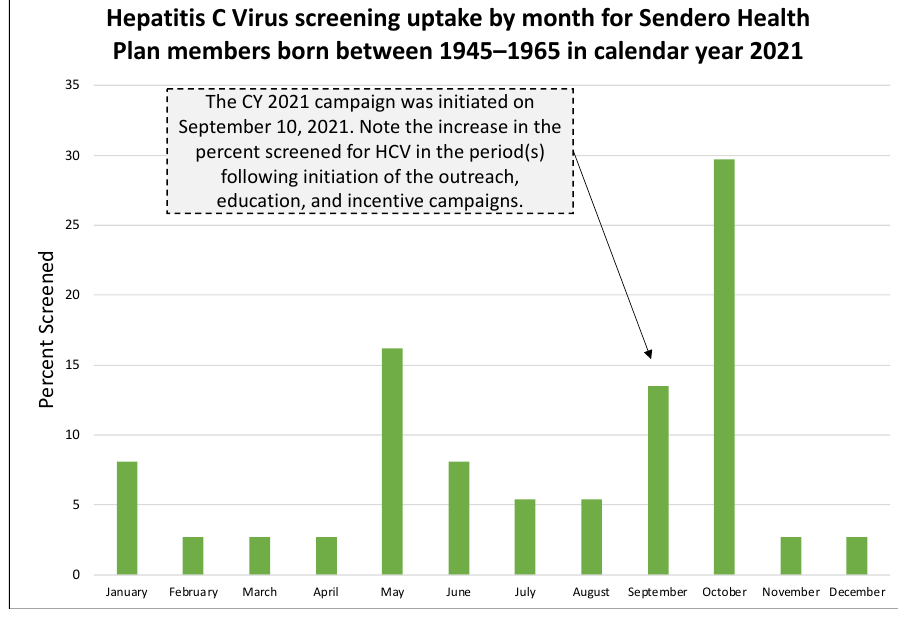
Figure 3. Hepatitis C Virus uptake by month for Sendero members born between 1945 – 1965 in calendar year 2021. Table 1. Count of Hepatitis C Virus (HCV) Screenings for the Study Cohort in Calendar Years 2019 – 2021, by Month.